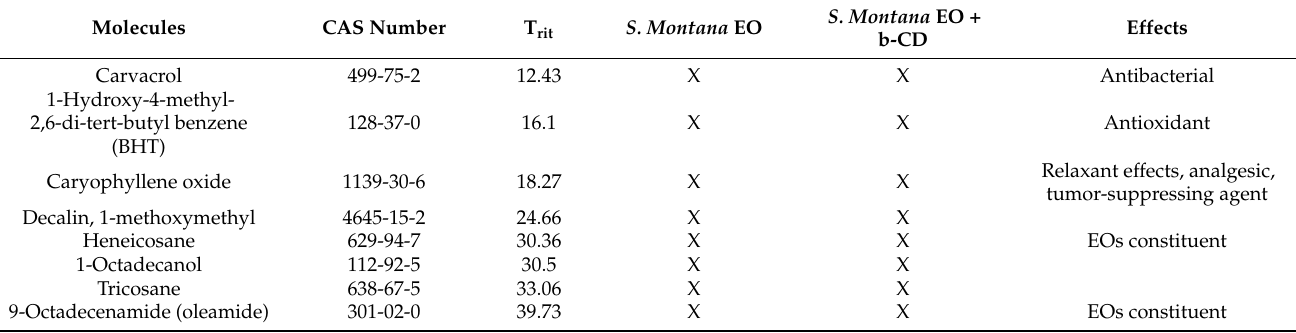
Table 1. Molecules found in both the S. montana EO and the relative tablet that show a biological function or are typical of this EO.